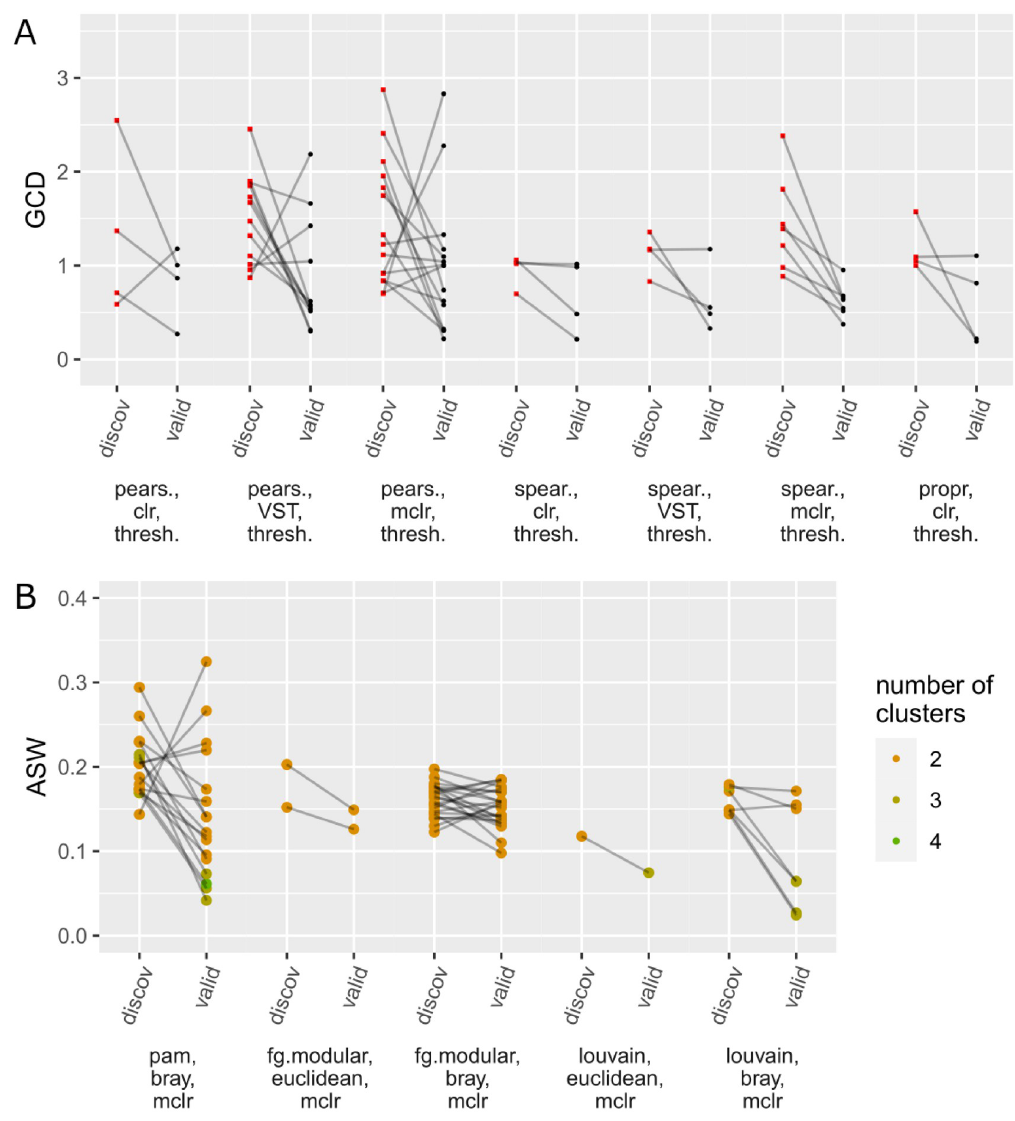
Fig 3. Research tasks 3 & 4: Analogously to Fig 2 (see the description there), values of the evaluation criteria are compared between discovery and validation data for n = 250. a) GCD values for the differential network analysis task, b) ASW values for the task of clustering